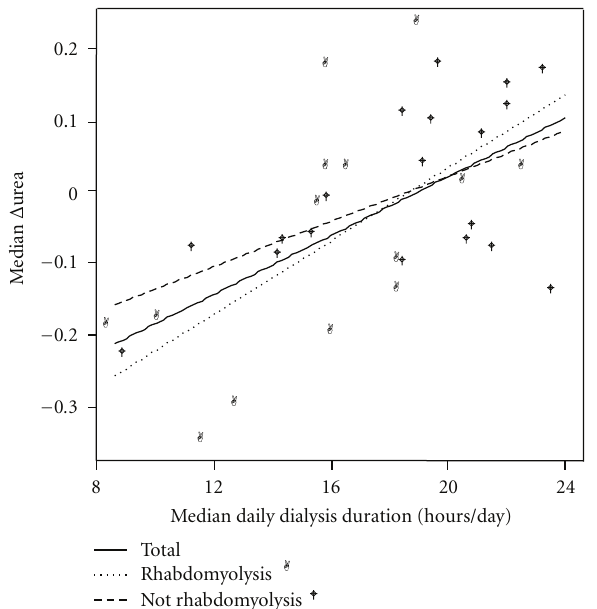
Figure 2: Scattergram of median daily CRRT duration and median Δ urea in the total population and the subgroups with and without rhabdomyolysis. Linear regression analysis showed a significant relationship between median daily CRRT duration and median Δ urea in the whole group, r = 0 . 60, P < 0 . 001.